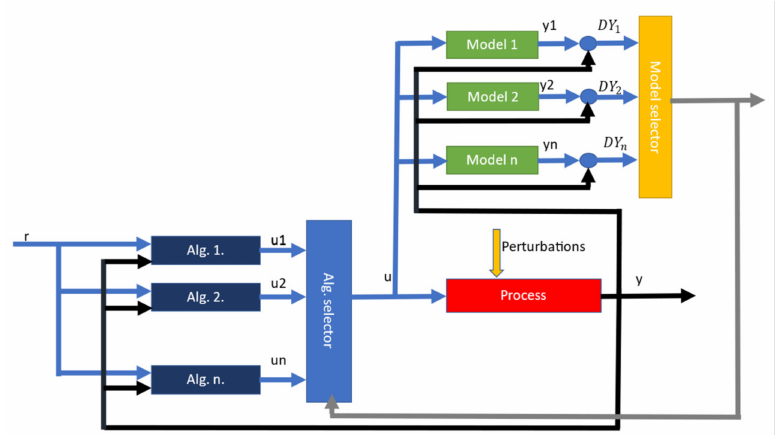
Figure 2. Overview of multimodel control scheme. The blue blocks on the left represents the algorithm selector block; the yellow and green blocks on the top right represents the model selection block. A model is chosen using inputs from the real process. Based on the chosen model, a control algorithm is chosen to issue new commands to the